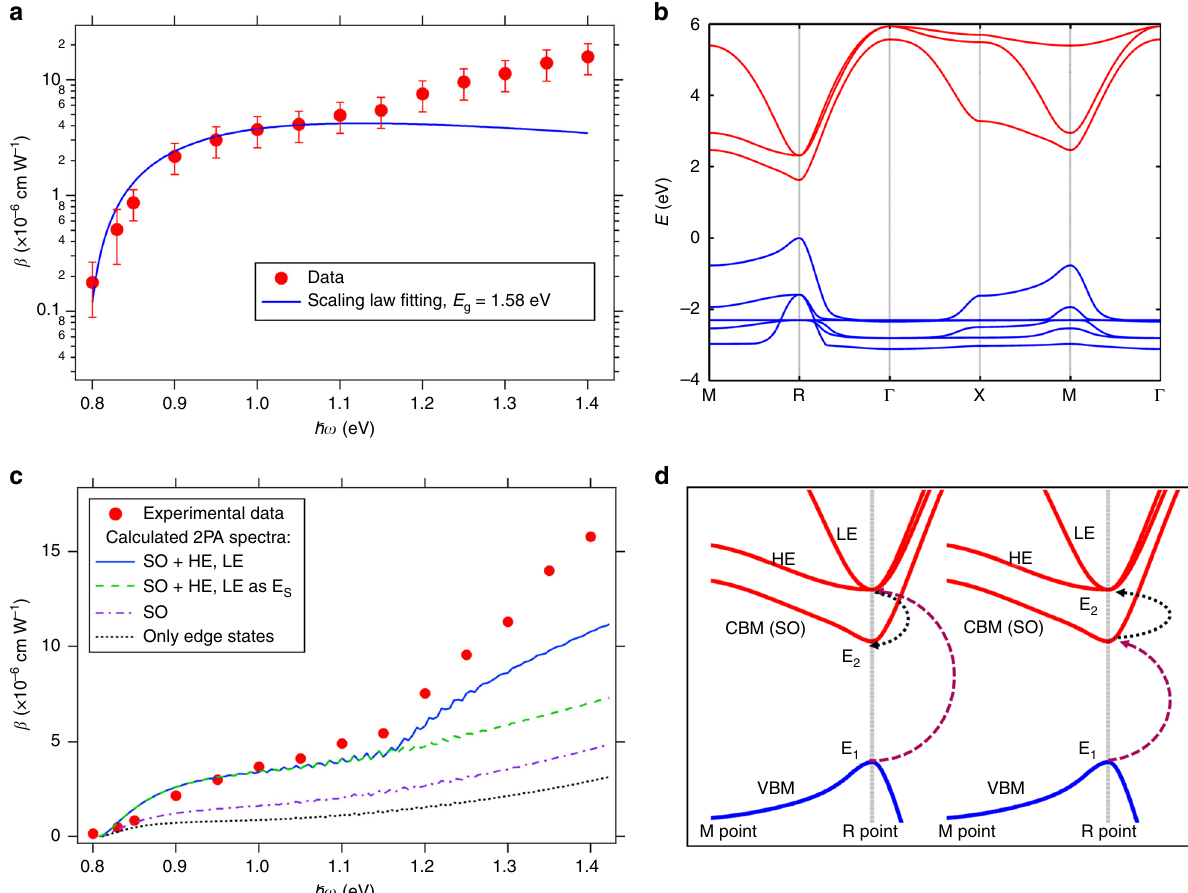
Fig. 2 2PA spectra and electronic band structure. a Experimental 2PA spectrum for CH 3 NH 3 PbI 3 compared to the scaling law, where 30 % error bars arise from sample variation. 50% error bars were introduced at 0.8 and 0.83 eV due to the limited data available. b Electronic band structure of cubic CH 3 NH 3 PbI 3 computed from an empirical tight-binding model. The fi gure is limited to 6 bands in the conduction band (red lines) and 10 bands in the valence band (blue lines). The bottom of the conduction band (CBM or SO bands) and the top of the valence bands (VBM) are both twice degenerated. The same model is used to compute the 2PA spectrum. c Full 2PA spectrum computed using the empirical tight-binding model (straight line). The dashed line represents the 2PA spectrum obtained by considering only the optical transitions to the bottom of the conduction band (spin-orbit split-off (SO) bands), but heavy (HE) and light (LE) electron states are still considered as virtual intermediate states (E s ). The dashed and dotted line corresponds to a computation where HE and LE bands are totally ignored. The dotted line represents the 2PA spectrum obtained by considering only the band edge states. d Some of the microscopic 2PA processes are schematically indicated by zooming the electronic band structure close to the bandgap. E 1 and E 2 are the initial and fi nal electronic states, respectively. HE and LE are considered either as virtual intermediate or fi nal